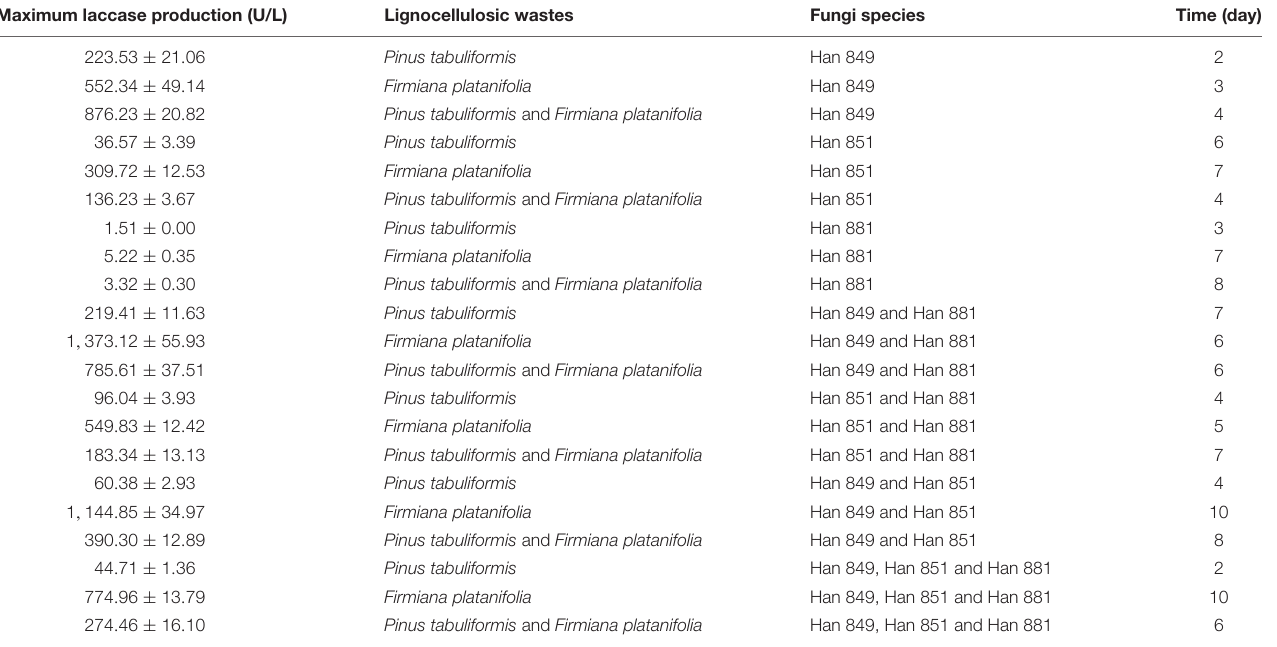
TABLE 3 | Maximum laccase production, Lignocellulosic wastes, and time of Cerrena unicolor Han 849, Lenzites betulina Han 851, and Schizophyllum commune Han 881. Maximum laccase production